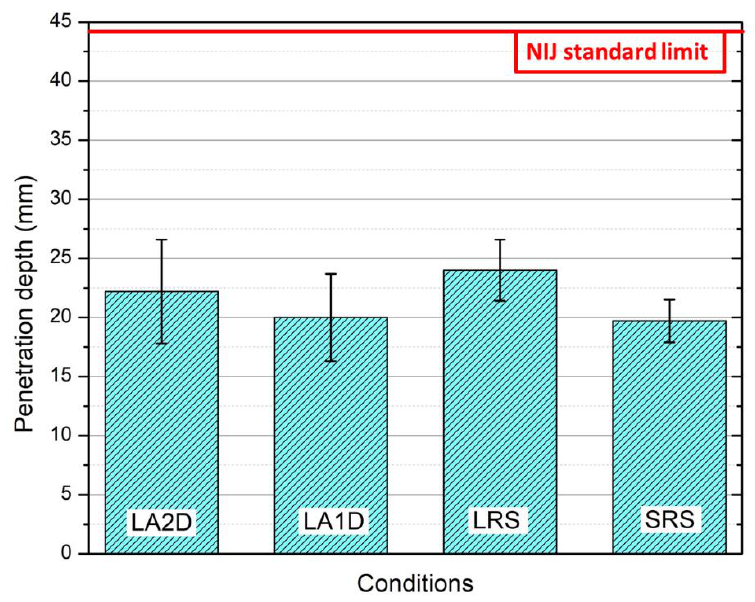
Figure 7. Penetration depth measurements for investigated MASs.